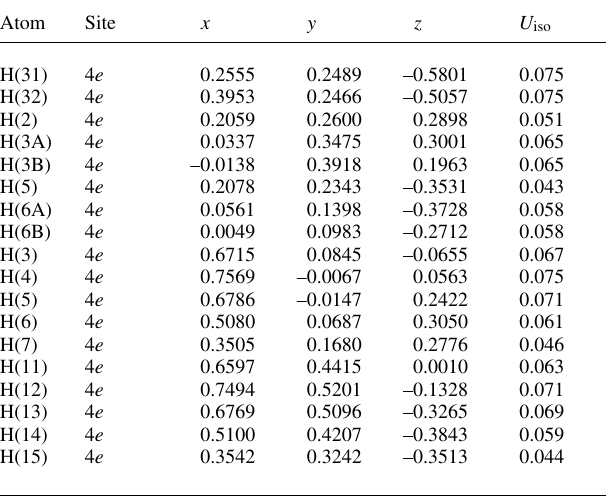
Table 2. Atomic coordinates and displacement parameters (in Å 2 )